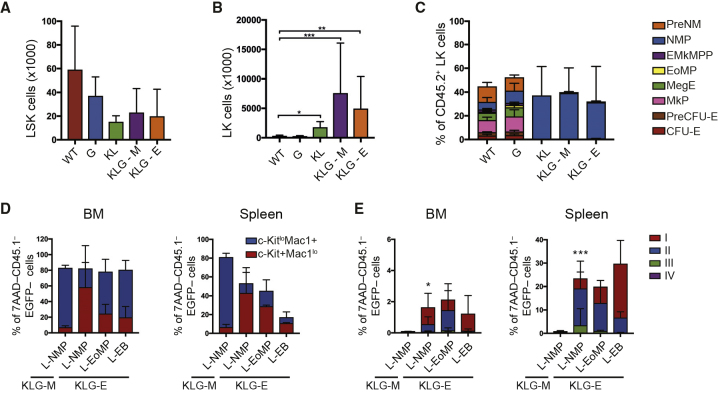
Cebpa and Gata2 Mutant AEL Is Sustained by LICs with an NMP Immuno-Phenotype(A) Absolute number of LSK in the BM of terminal analyzed primary transplanted mice of the indicated genotypes. The results are presented as the mean ± SD. Statistical significance was determined using the Mann-Whitney U test. ∗p < 0.05, ∗∗p < 0.01, ∗∗∗p < 0.001. WT, n = 7; G, n = 9; KL, n = 4; KLG-M, n = 4; KLG-E, n = 3 from a total of five independent experiments.(B) Absolute number of LK cells in the BM analyzed as in (A). The results are presented as the mean ± SD. WT, n = 7; G, n = 9; KL, n = 5; KLG-M, n = 8; KLG-E, n = 5 in five independent experiments.(C) Myelo-erythroid progenitors as a percentage of donor LK cells in the BM in mice from (B). The results are presented as the mean ± SD.(D) Terminal analysis of secondary recipients transplanted with purified L-NMPs, L-EoMPs, and L-EB cells. Histogram showing c-KitloMac1+ and c-Kit+Mac1lo cells as a percentage of 7AAD–CD45.1–EGFP– cells in the BM (left panel) and spleen (right panel). The results are presented as the mean ± SD. KLG-M L-NMP, n = 2; KLG-E L-NMP, n = 5; KLG-E L-EoMP, n = 2; KLG-E L-EB, n = 2 in three independent experiments.(E) Histogram showing stage I–IV erythroblast cells as a percentage of 7AAD–CD45.1–EGFP– cells in the BM (left panel) and spleen (right panel) in mice from (D). The results are presented as the mean ± SD. ∗p < 0.05, ∗∗∗p < 0.005 (combined stage I and II EB; Student's t test, compared with KLG-M L-NMP). PreNM, pre-neutrophil-monocyte progenitor; EMkMPP, erythroid-megakaryocyte primed multi-potent progenitor; MegE, megakaryocyte erythroid progenitor; PreCFU-E, pre-colony forming unit erythroid progenitor; CFU-E, colony forming unit erythroid progenitorSee also Figures S5–S7 and Tables S2 and S3.